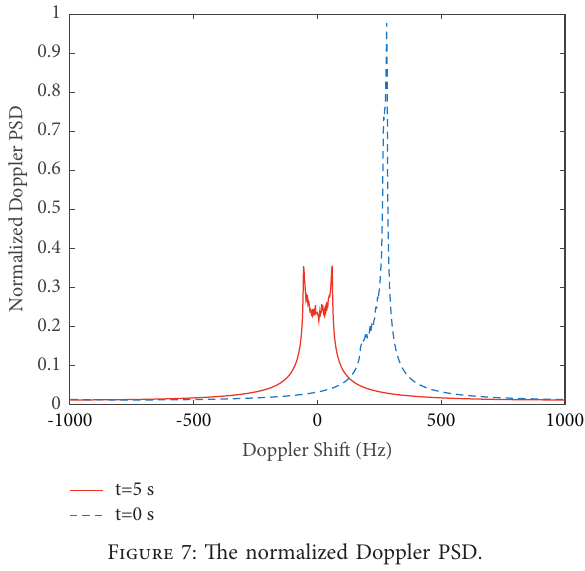
Figure 7: The normalized Doppler PSD.